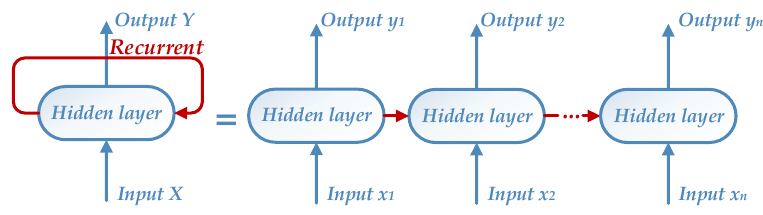
Figure 4. T he sequential structure of recurrent neural network (RNN).